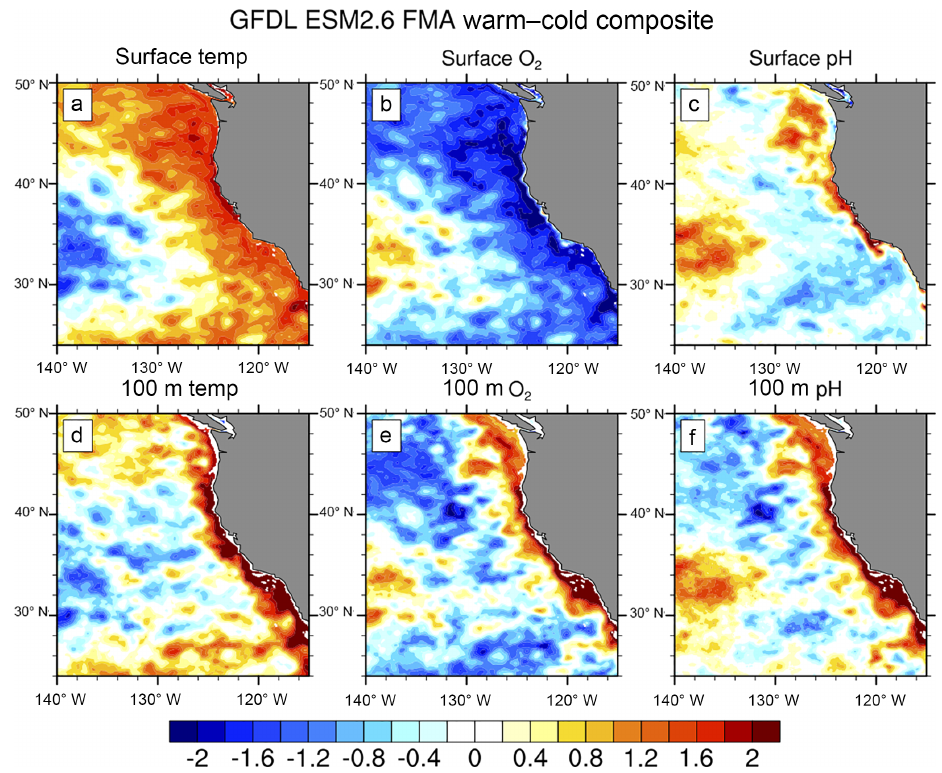
Figure 6. ESM2.6 FMA warm–cold high-pass-filtered standardized anomalies (unitless) for (a) sea surface temperature, (b) surface O 2 , (c) surface pH, (d) 100m temperature, (e) 100m O 2 , and (f) 100m